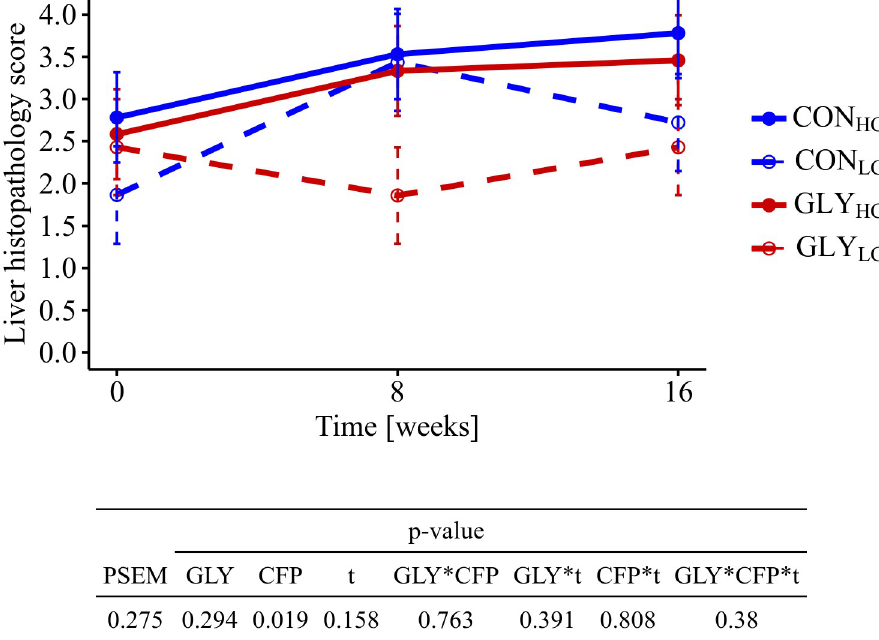
Fig 2. Influence of glyphosate residues and different concentrate feed proportions in diets of cows on liver histopathology. Cows were fed with either a GLY-contaminated (GLY groups) or a control (CON groups) diet consisting of high (HC, 60%) or low (LC, 30%) concentrate feed proportions (CON HC , n = 8; CON LC , n = 8; GLY HC , n = 8; GLY LC , n = 7). HE-stained liver sections were evaluated regarding the presence of ten different parameters and summarized in a cumulative overall liver histopathology score (0 = inconspicuous, 10 = conspicuous). Values are presented as LS means ± standard error of the mean. Parameters were analyzed with values from week 0 as covariate. PSEM = pooled standard error of the mean; CON = control; GLY = glyphosate; CFP = concentrate feed proportions; t = experimental time; CON = control; HC = high concentrate proportion in the diet; LC = low concentrate proportion in the diet.